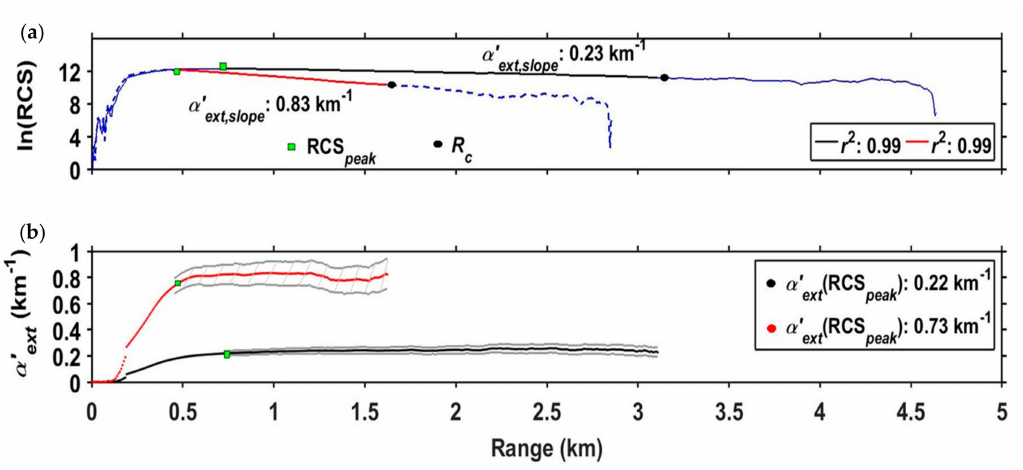
Figure 3. Range profiles of ( a ) the range-corrected lidar signal and ( b ) total extinction, α (cid:48) the two cases of clear-sky (midday of 12 November, black) and high aerosol loading (midday of 29 November, red). In ( b ), error ranges are indicated with hatching.